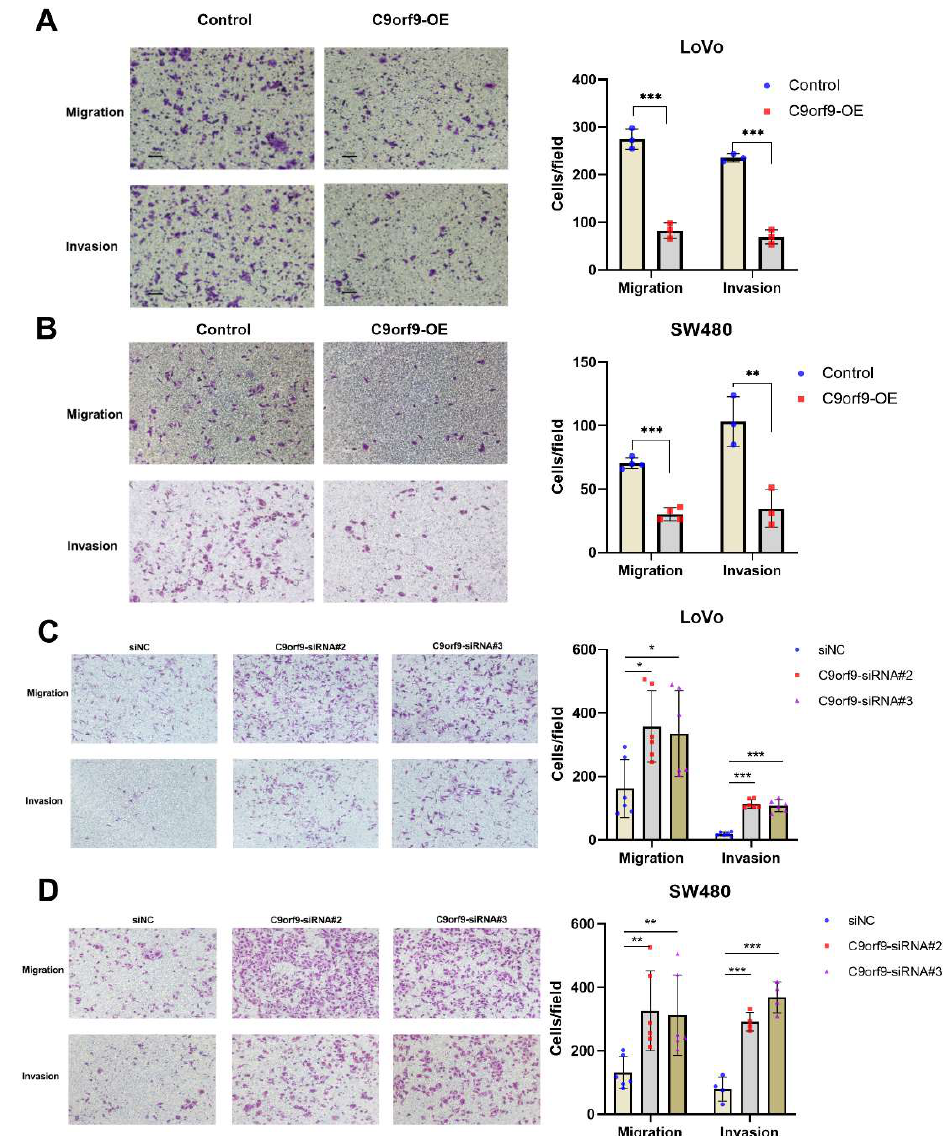
Figure 4. C9orf9 regulates LoVo and SW480 cell migration and invasion capacity. Transwell assays (Matrigel-free) or Transwell invasion assays (coated with Matrigel) were performed, respectively, in control and C9orf9-overexpression LoVo ( A ) and SW480 ( B ) cells. ( C ). Cell migration and invasion assays in control and C9orf9-knockdown LoVo cells. ( D ). Cell migration and invasion assays in control and C9orf9-knockdown SW480 cells. * p < 0.05, ** p < 0.01, *** p < 0.001.